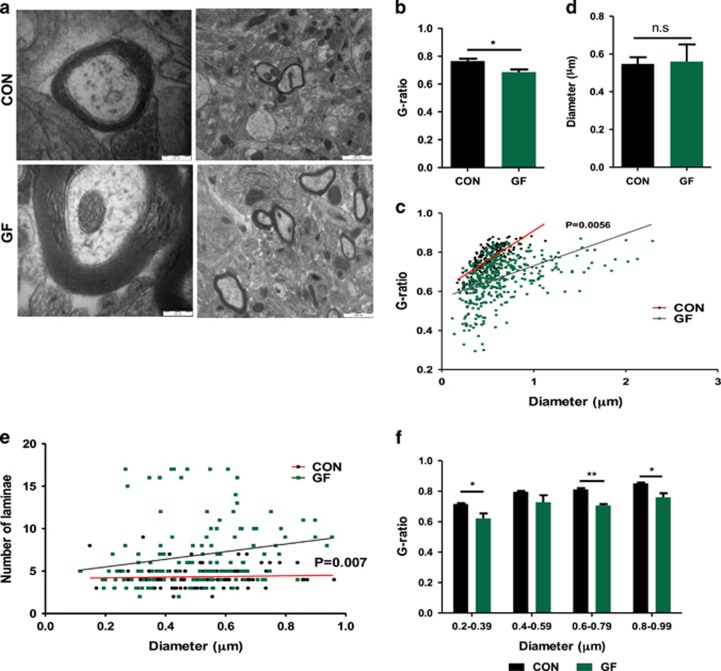
Increased myelin sheath thickness in the prefrontal cortex (PFC) of male germ-free (GF) mice. (a) Electron micrographs of axons in the PFC of conventionally raised (CON) and GF mice. Scale bars=200 and 1000 nm. (b) Average g-ratio per animal in the PFC. (c) Scatter plot of g-ratio values in the PFC in CON (n=187 axons) and GF (n=390 axons) against axon diameter. (d) Average axonal diameter per animal. (e) Scatter plot of axon diameter against the number of lamina counted for that individual axon. (f) g-ratio for individual axonal population based on diameter range. Bar graphs shown as mean±s.e.m. NS (not significant) P>0.05; *P<0.05; **P<0.01.